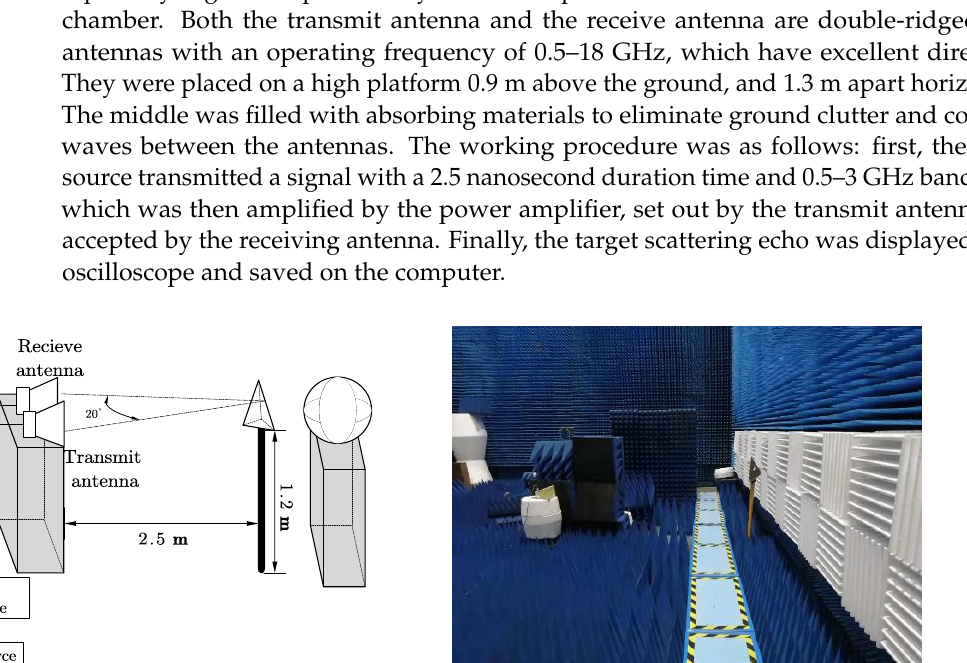
Figure 1. Maxwell’s grid division.